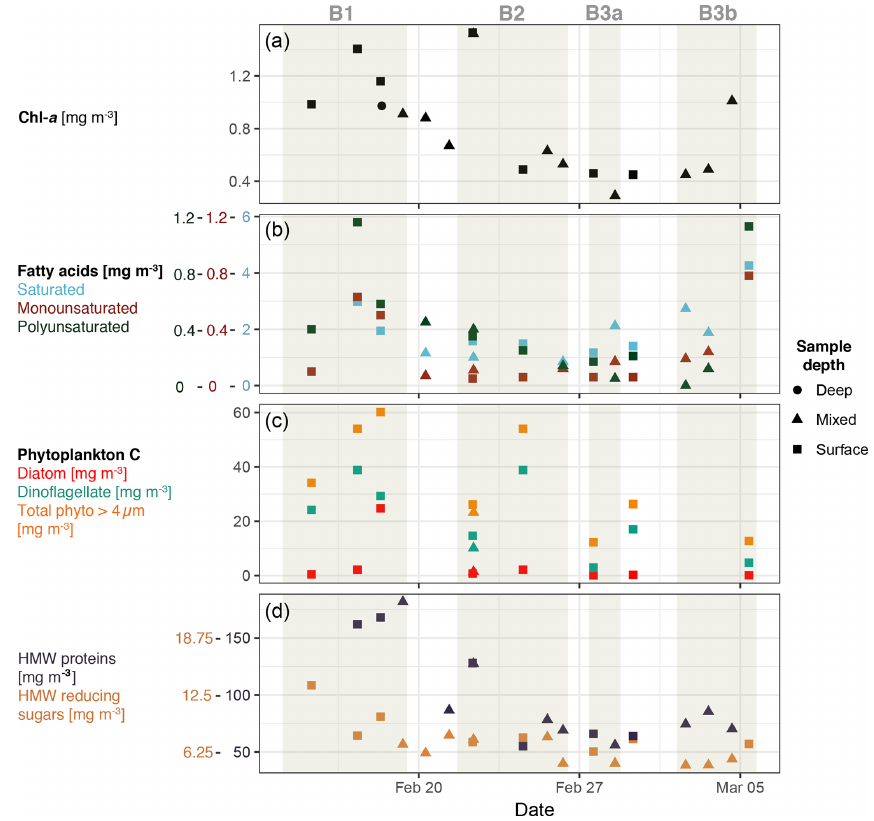
Figure 3. Characterisation of biological activity for water samples used to generate SSA. Note that this is a selected subset of all water parameters. Panels show the concentration of Chl a (a) , fatty acids (b) , phytoplankton carbon (c) , and total high-molecular-weight (HMW) reducing sugars and proteins (d) . Note that total HMW proteins and reducing sugars include particle and dissolved fractions. Shapes represent the water sample depth class (surface 0.1m, mixed 3–12m and deep >